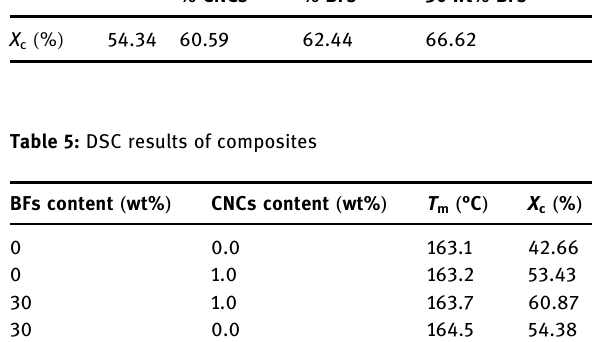
Table 4: Crystallinity of composites and pure PP Samples PP